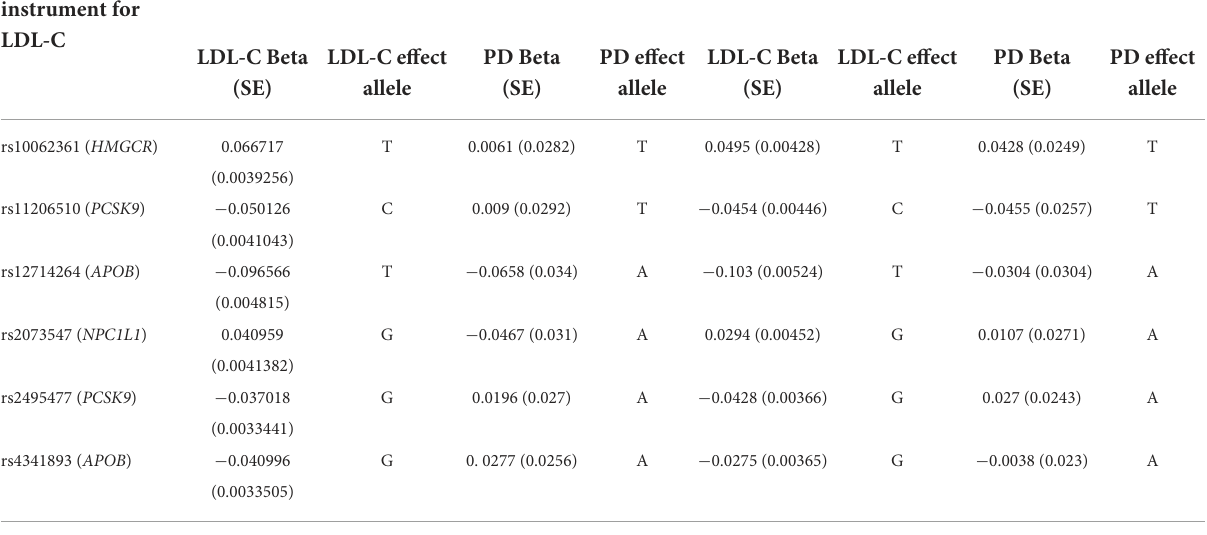
TABLE 1 Genetic instrumental variables for the sex-specific cis-Mendelian randomization analysis between LDL-C gene targets and late-onset PD. Genetic instrument for LDL-C